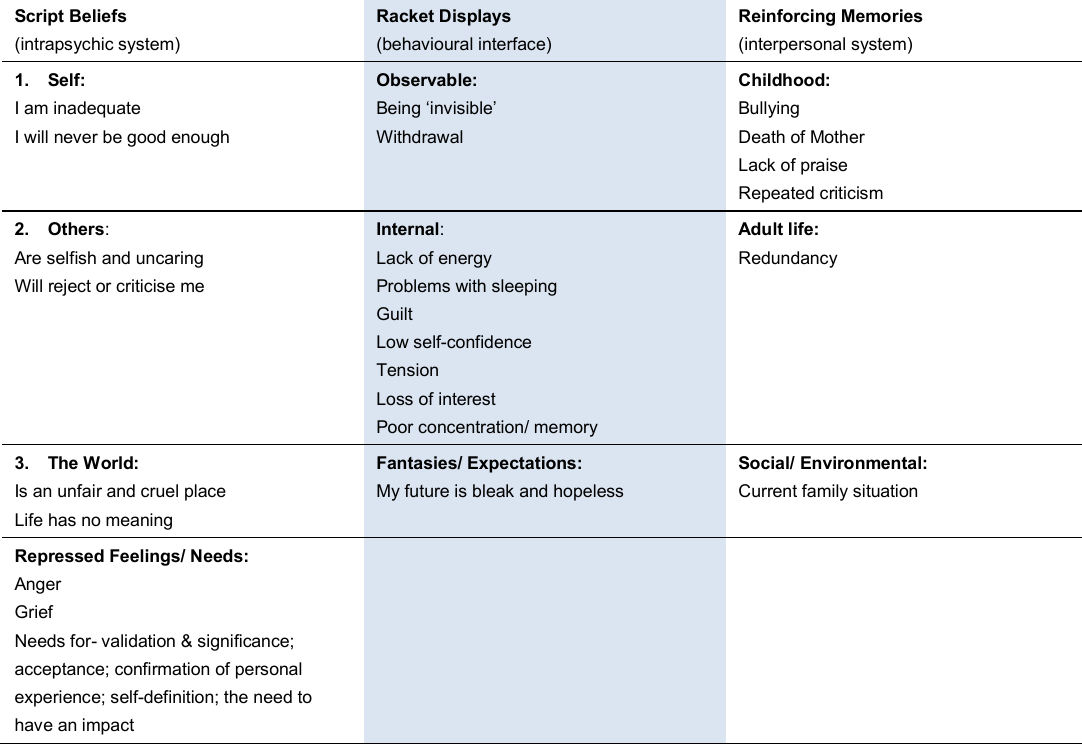
Table 4: Peter’s Racket (Script) System (Erskine and Zalcman, 1979; O’Reilly-Knapp and Erskine, 2010) Script